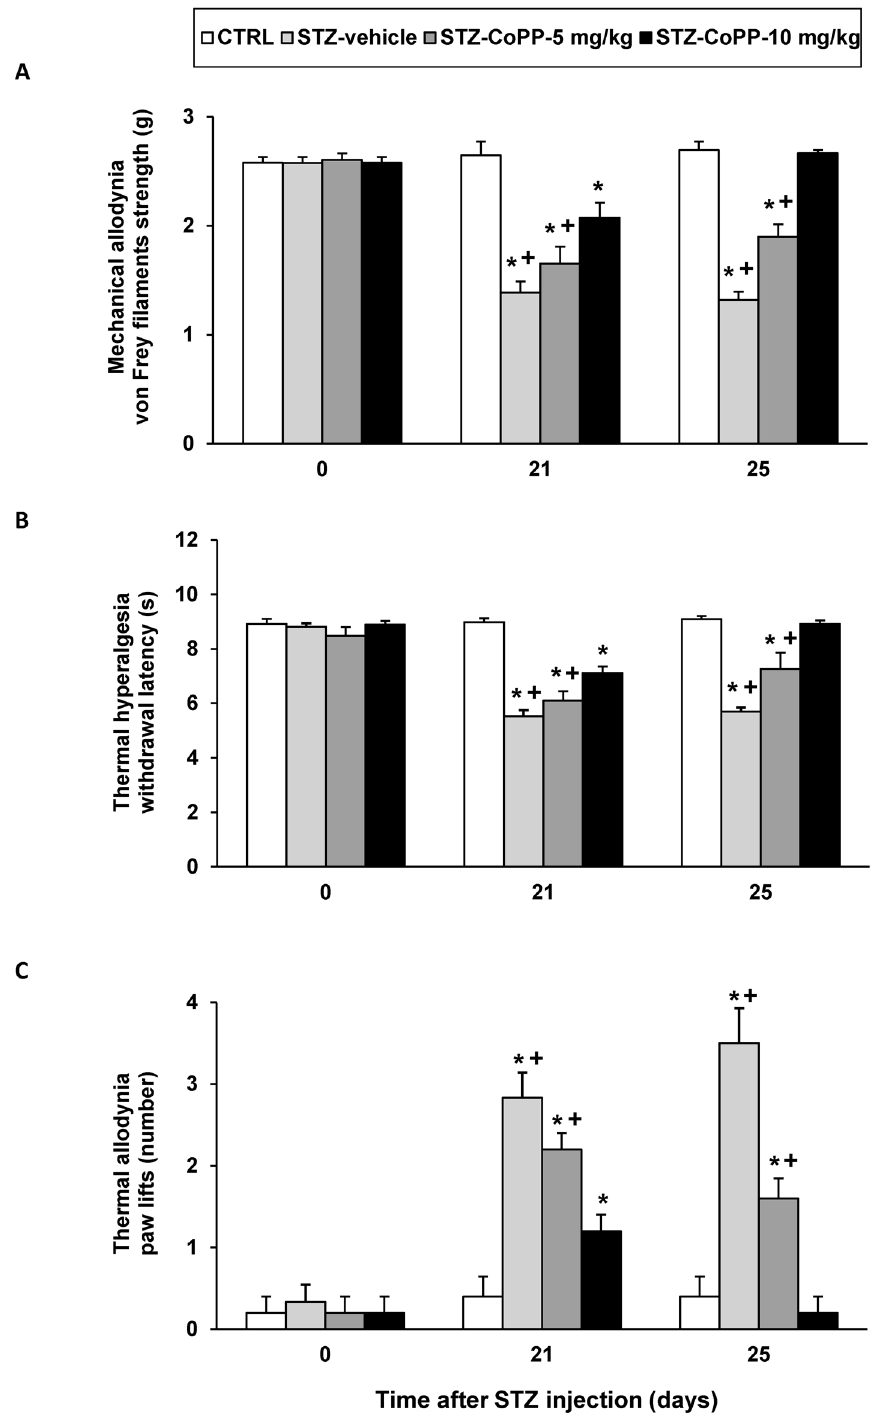
Fig 1. The antinociceptive effects produced by the intraperitoneal administration of CoPP at 5 and 10 mg/kg in STZ injected mice. The development of mechanical allodynia (A), thermal hyperalgesia (B) and thermal allodynia (C) in the hind paws of control and diabetic mice intraperitoneally treated with vehicle or CoPP at 5 and 10 mg/kg from day 21 to day 25 after STZ injection is shown. Data of tests are shown at day 0 (before diabetes induction) and at days 21 and 25 after STZ injection (one and five days after initiation of CoPP administration, respectively). Data are expressed as von Frey filaments strength (g) for